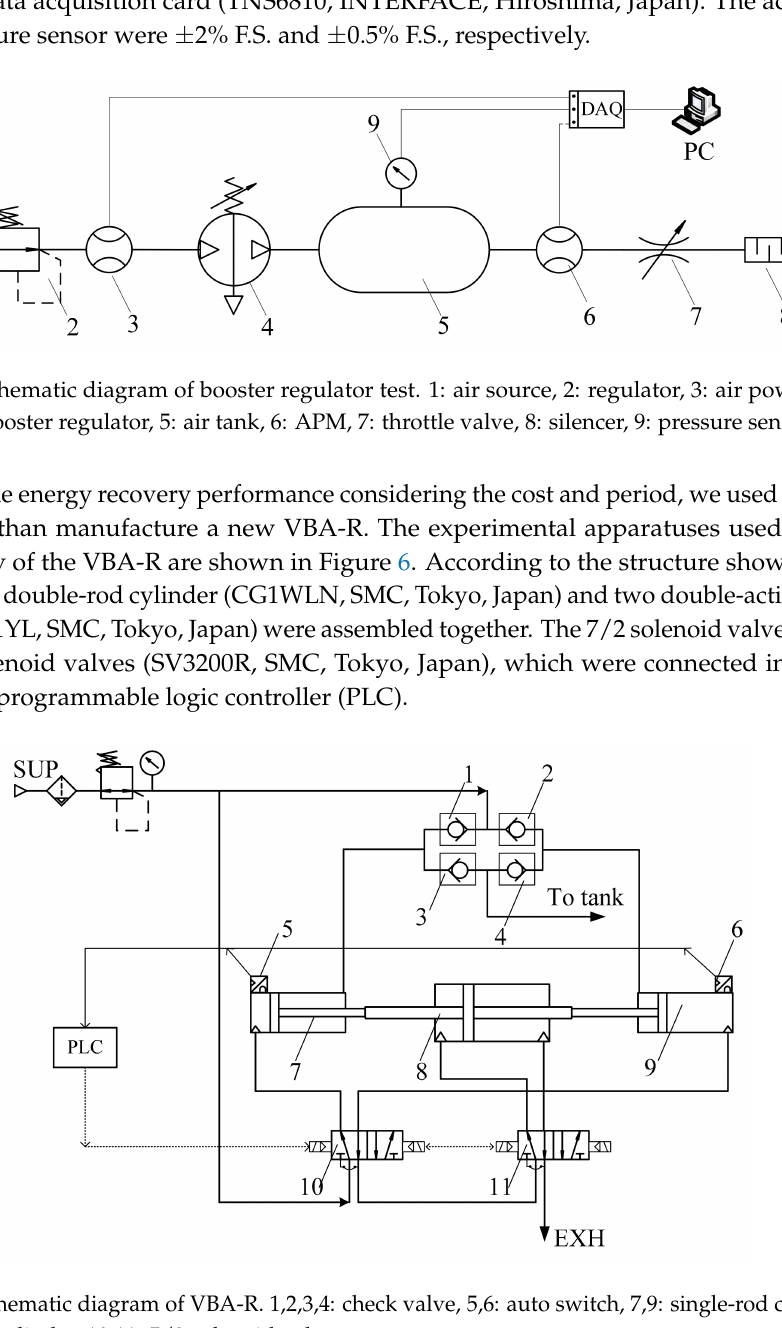
Figure 6. Schematic diagram of VBA-R. 1,2,3,4: check valve, 5,6: auto switch, 7,9: single-rod cylinder, 8: double-rod cylinder, 10,11: 5/2 solenoid